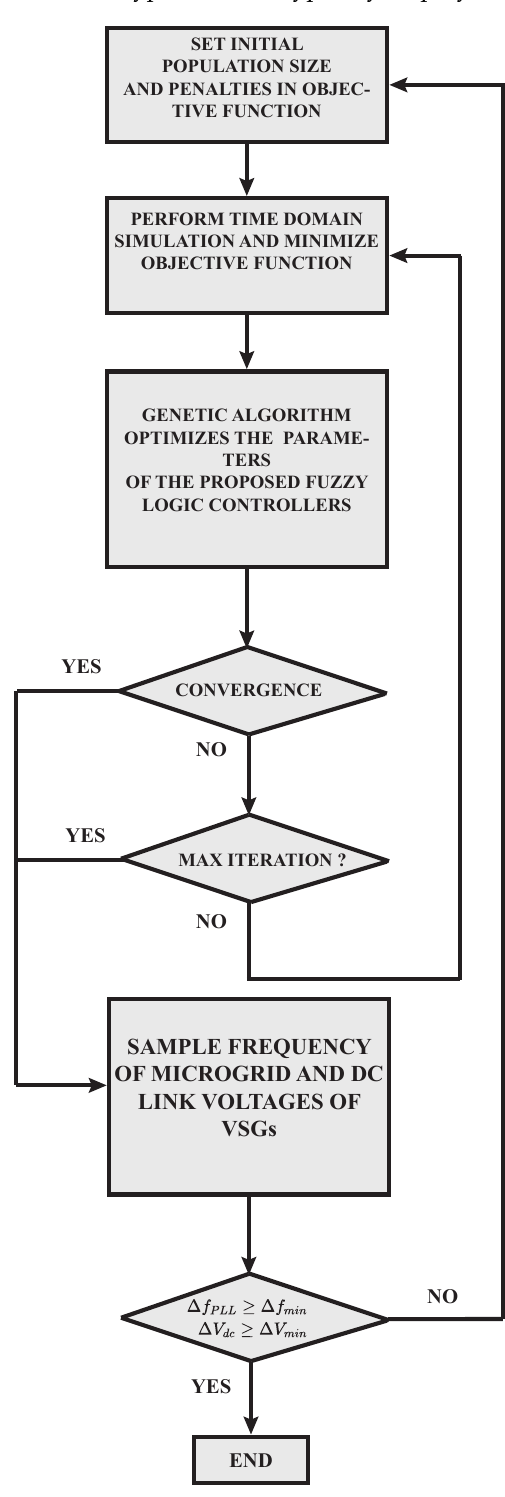
Table 4. The tuned input membership functions are shown in Figures 9 and 10, the tuned fuzzy rules are listed in Tables 5 and 6, and the tuned output membership functions are shown in Figures 11 and 12. The output membership functions in Figures 11 and 12 are of the constant type, which is typically employed in Sugeno fuzzy systems.